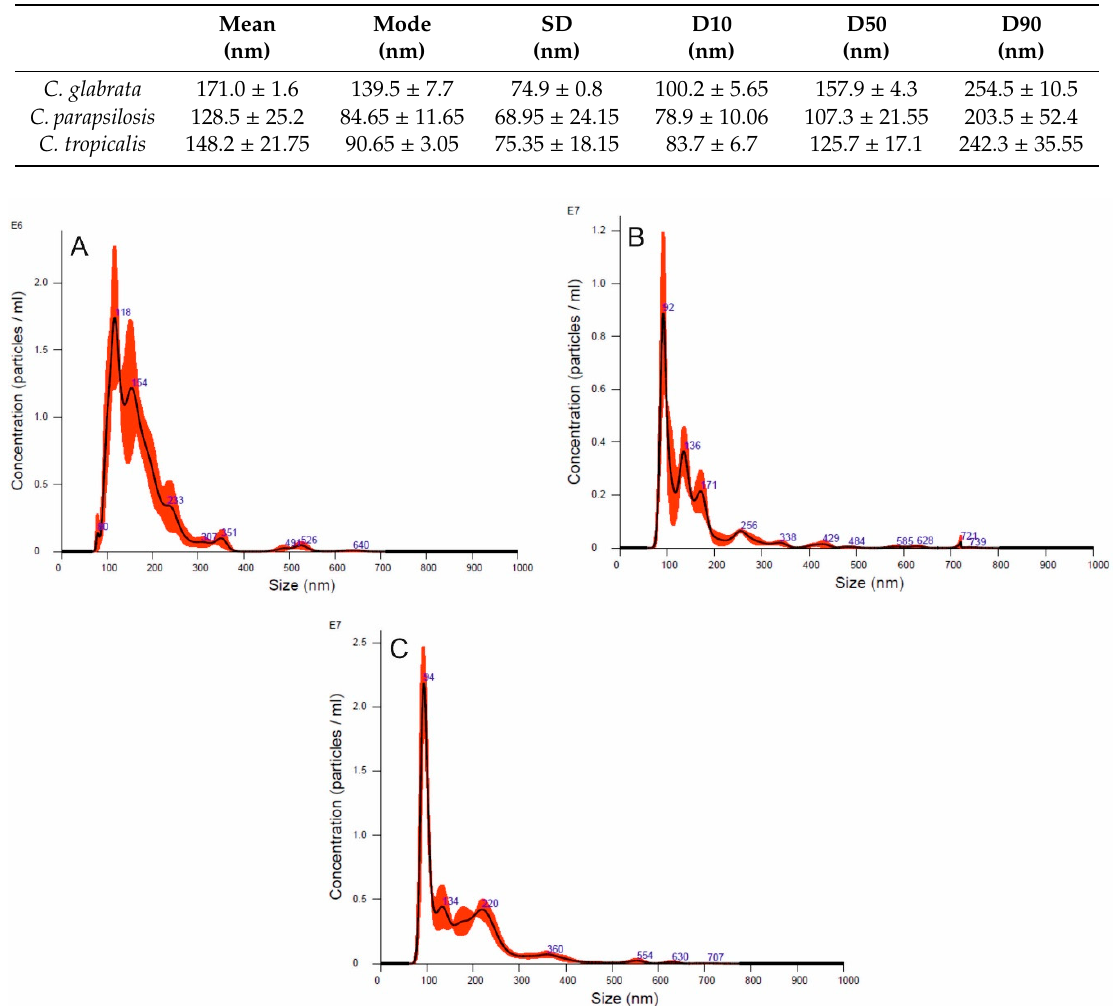
Table 2. Average EV sizes measured by NTA. Parameters D10, D50 and D90 indicate that 10%, 50% or 90% of the EV population, respectively, had a diameter of less than or equal to the specified value. Data are presented as means ± SEM.